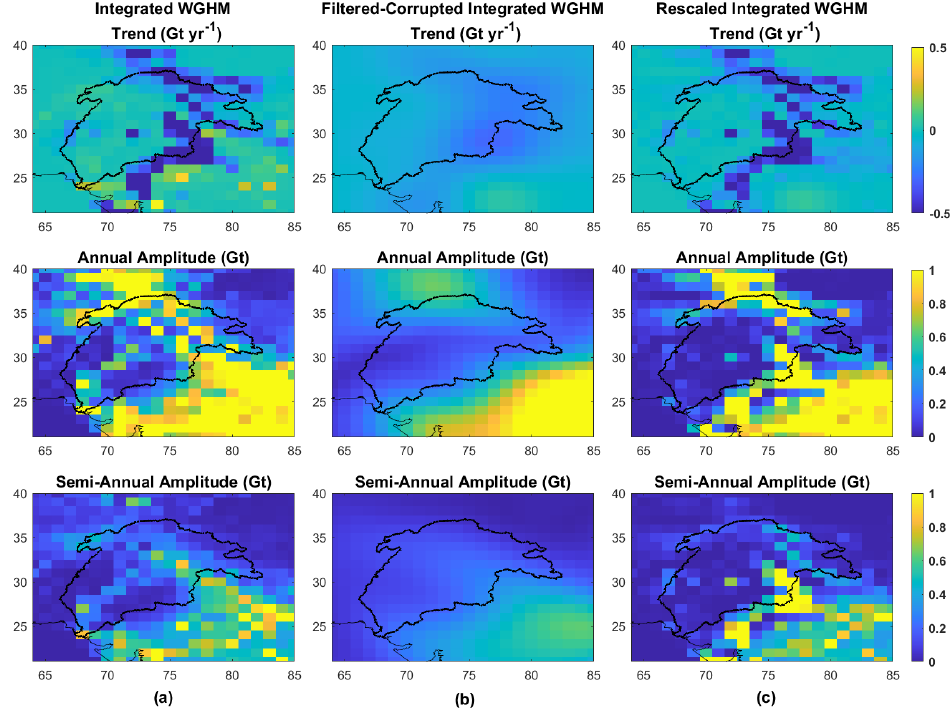
Figure 18. True (a) and recovered (c) spatial patterns of different mass change components from grid scaling of filtered–corrupted integrated WGHM fields (b) in the simulation